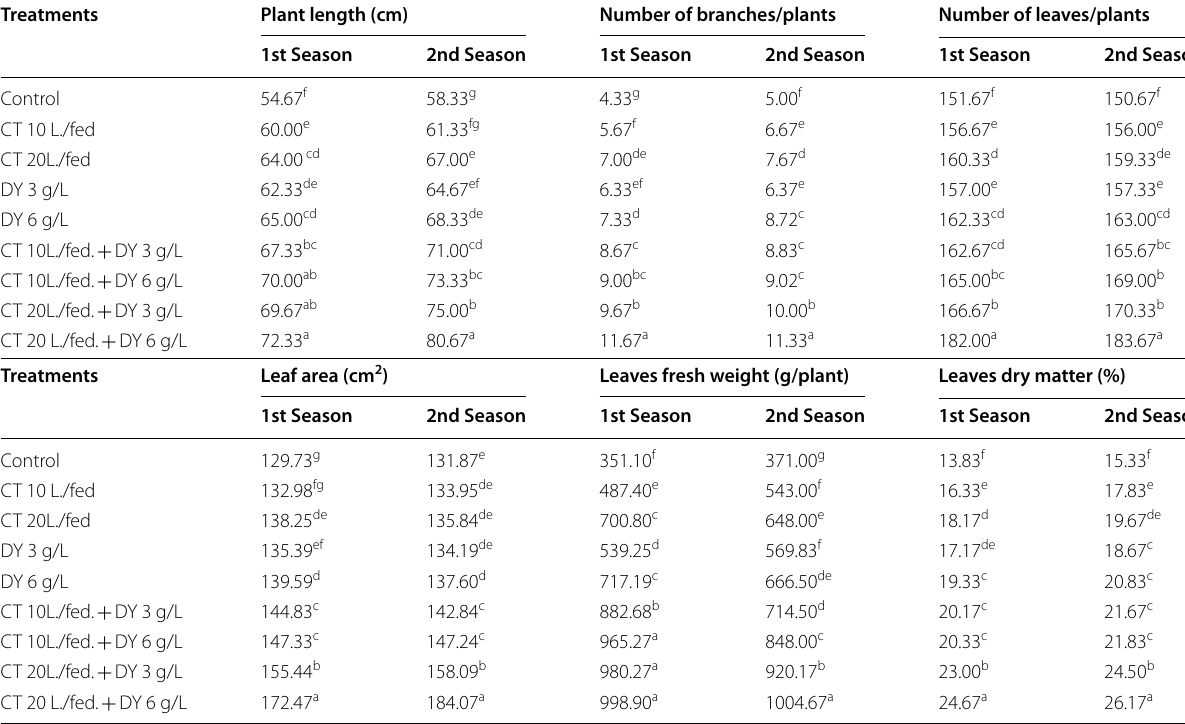
* Values followed by the same letter (s) are not significantly different at 5%